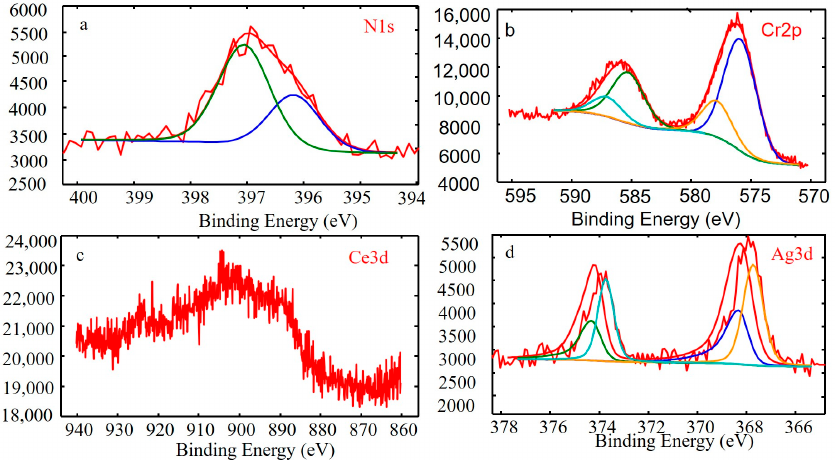
Figure 8. XPS spectra of the worn surface of the CrAgCeN coating deposited at 0.6 Pa ( a ) N1s, ( b ) Cr2p, ( c ) Ce3d, ( d ) Ag3d. ( b ) Cr2p, ( c ) Ce3d, ( d )